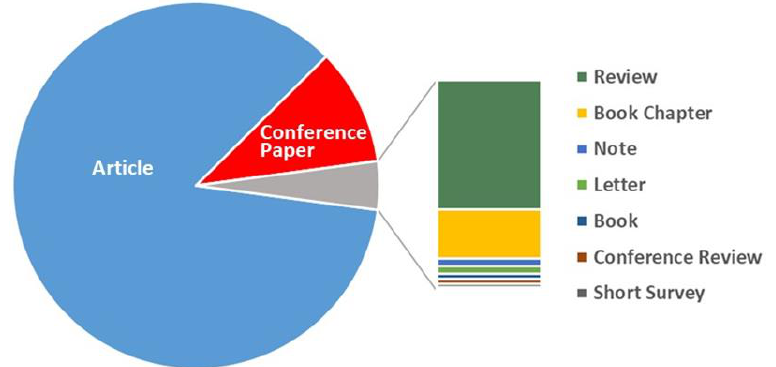
Figure 2. Distribution of document types for block copolymers.